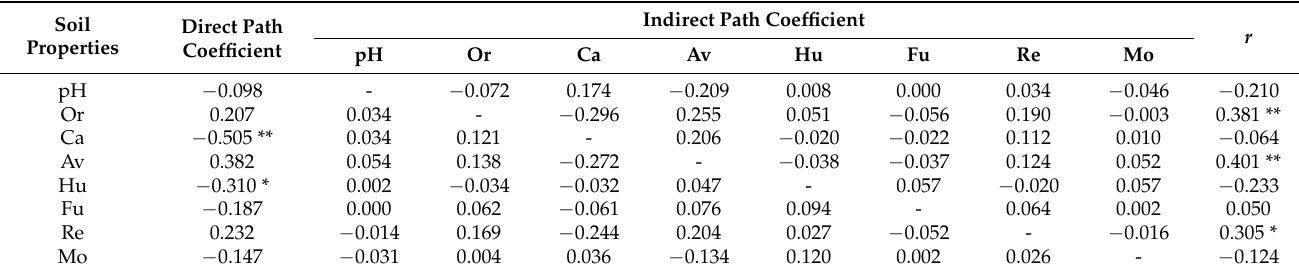
Table 4. Path analysis between soil properties and DTPA-Cu.